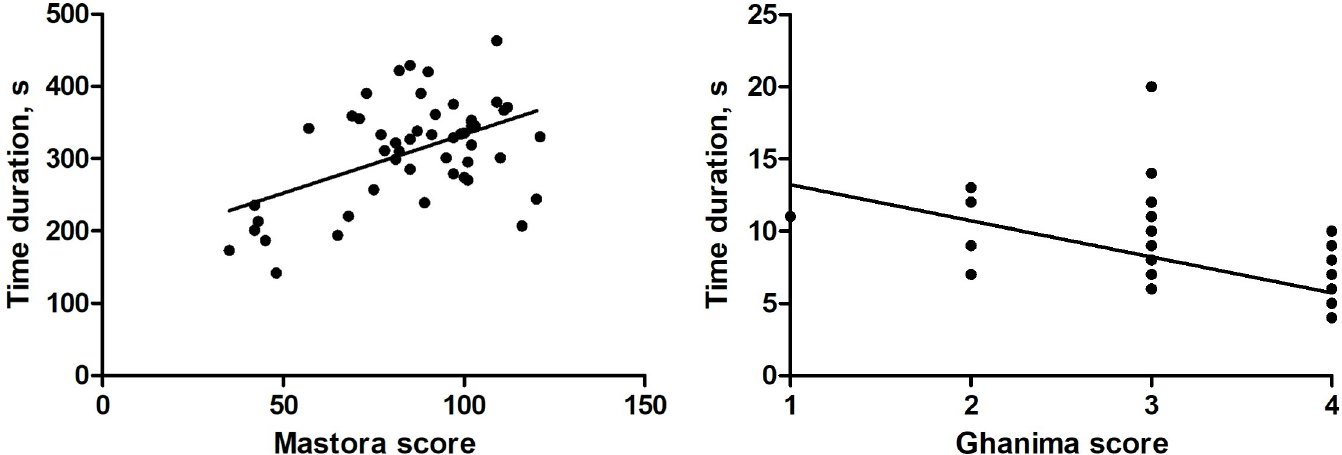
Fig 4. A. Spearman’s correlation analysis between time duration and the investigated scores. A weak positive correlation was identified with the Mastora score (r = 0.35, p = 0.014). B. A significant inverse correlation with the time duration was identified with the Ghanima score (r = -0.67, p < 0.0001).